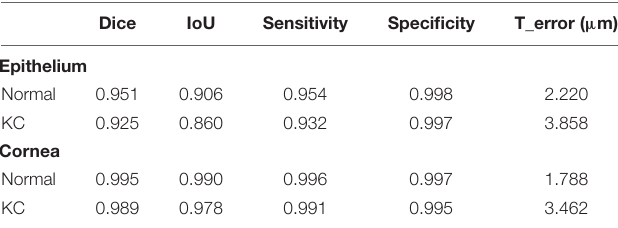
TABLE 2 | Quantitative evaluation for corneal tissue segmentation and thickness measurement between our model and clinicians. Dice IoU Sensitivity Specificity T_error ( µ m)